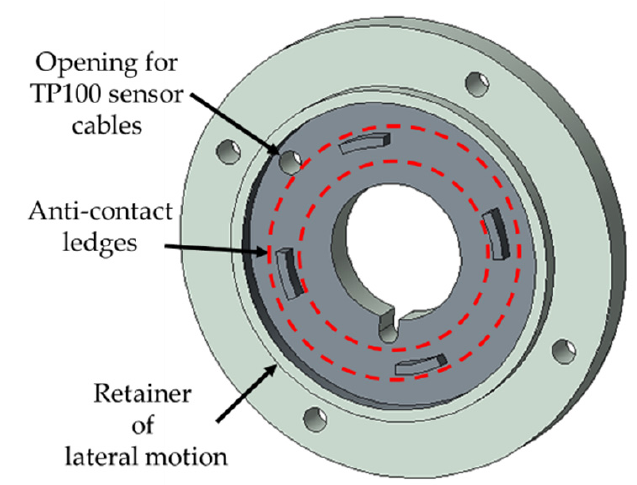
Figure 8. Internal features of the frontal disc.